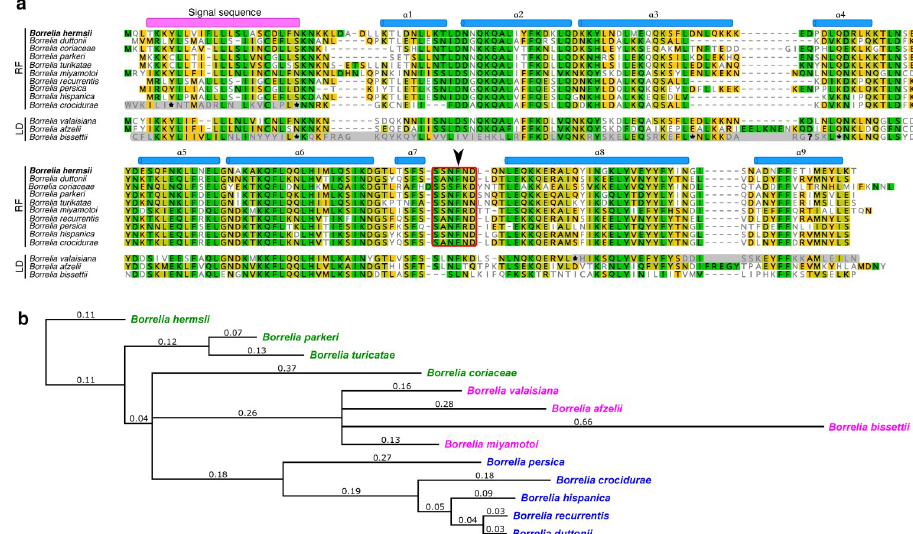
Fig 4. A new family of immune evasion proteins in borreliae revealed by bioinformatics searches. (a) Multiple sequence alignment of the FhbA-related proteins. The signal sequence is marked in magenta and secondary structure elements derived from the crystal structure of BhFhbA:FH19-20 are shown in blue above the sequence. The conserved hinge region is marked with a red rectangle, and an arrowhead points at the key Phe residue important for tight binding to FH20. The sequence alignment consists of protein sequences, predicted protein sequences and translated genomic regions that match the BhFhbA used as the search sequence (see Materials and Methods for details). Asterisk ‘ � ’ represents a stop codon and question mark ‘?’ stands for an incomplete codon, where a frameshift appears to have occurred. In generating the protein alignment, the frameshift was ignored, and the translation frame was preserved to allow further protein alignment after that problematic codon. Sequence parts with grey background are translated genomic sequences, which most probably are not present in derived proteins due to stop codons or frameshifts. Accession numbers and references for the sequences used in the alignment: B . hermsii YOR (W5SB08), B . coriaceae Co53 (W5T1N6), B . duttonii CR2A (W6TXL9), B . parkeri (D5GU46), B . turicatae (B0L8C8), B . miyamotoi (A0A075BUA1), B . recurrentis (C1L349), B . persica No12 Bp4780 (contig: NZ_AYOT01000066.1, nucleotides: 4020 - > 4611), B . hispanica CRI Bhis_2727 (contig: NZ_AYOU01000105.1, nucleotides: 3668 - > 4235), B . crocidurae str. Achema (contig: NC_017778.1, nucleotides: 46553 - > 45974), B . valaisiana VS116 (C0R979), Bo . afzelii (WP_011703930.1), B . bissettiae DN127 (contig: NC_015916.1, nucleotides: 3284 - > 2685). (b) Phylogenetic tree of the FhbA-family proteins constructed from the sequences shown in (a). The numbers represent the substitutions per position and the length of the lines is equivalent to these numbers. The three colours emphasize that the sequences cluster into three distinct